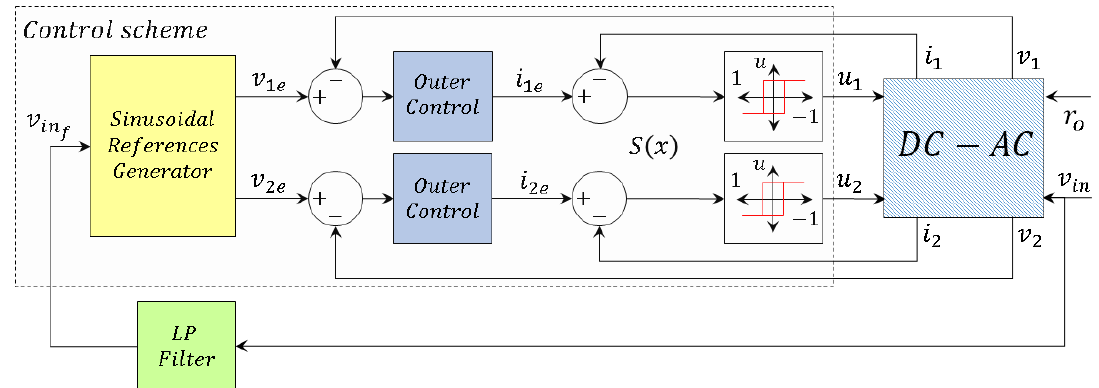
Figure 3. Block diagram of the complete control proposal: reference-generation and control.